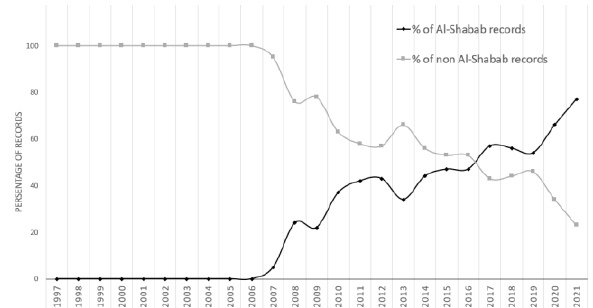
Figure 5. Percentage number of use of “Al-Shabaab” word by years.